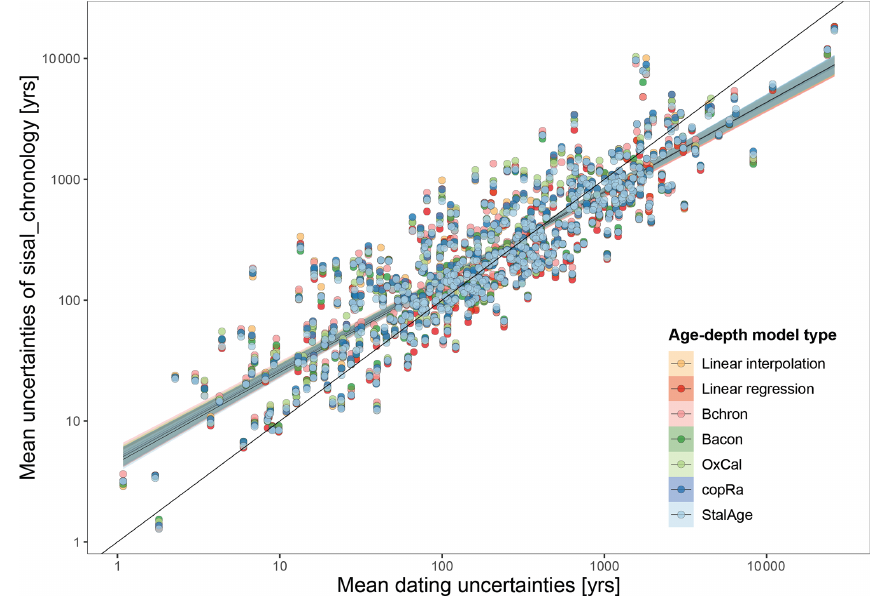
Figure 6. Scatterplot of average uncertainties in the sisal_chronology table and 230 Th / U mean dating uncertainties for each entity and age–depth model technique. The 1 : 1 line is shown in black.